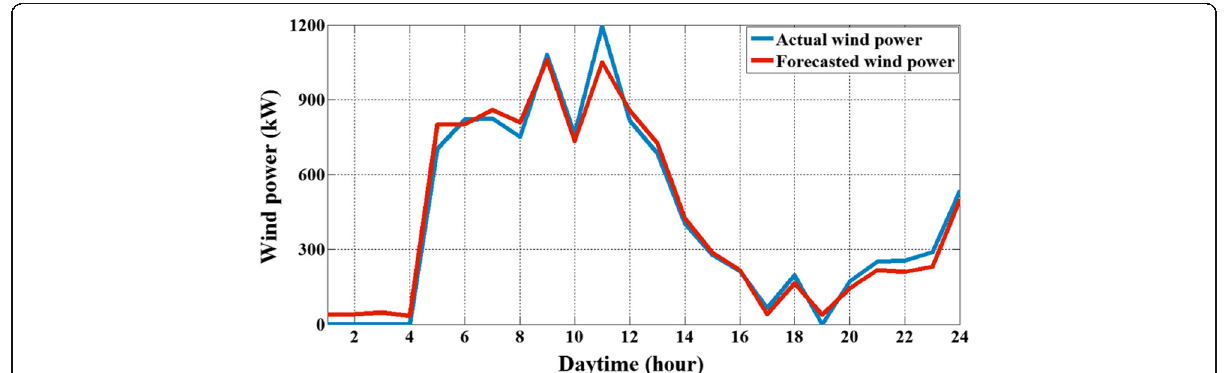
Fig. 4 Actual wind power vs. forecasted wind power for a winter day